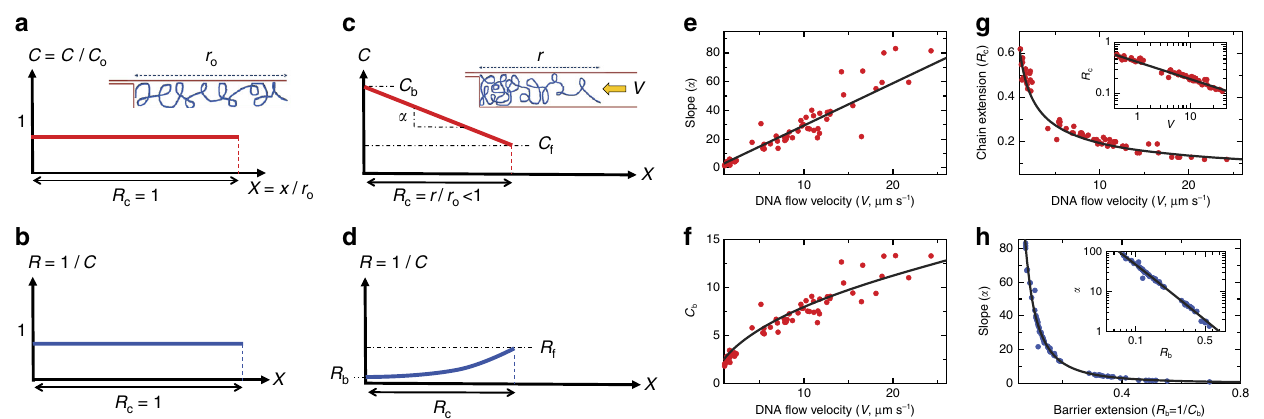
Fig. 2 Relation between the parameters de fi ned in concentration pro fi le. a The nanochannel con fi ned chain in no- fl ow equilibrium has a uniform concentration pro fi le C ( X ) = 1. Inset: schematic of no- fl ow equilibrium chain with extension r o . b Local extension R ( X ) ≡ 1/ C ( X ) for chain in no- fl ow equilibrium. c When a fl ow V is applied, in the long-time limit the chain reaches a steady-state with a concentration pro fi le that ramps linearly towards the barrier: C ( X ) = C b − α X. Inset: schematic of chain in fl ow-constrained equilibrium with extension r . d Local extension R ð X Þ (cid:3) 1 = C ð X Þ for chain in fl ow- constrained equilibrium. Note that for a uniform pro fi le R b = R c . e Pro fi le slope α , f barrier concentration C b , and g chain extension R c vs. V with fi ts to ffiffiffiffi p ffiffiffiffi p scaling relations predicted by piston theory ( e α (cid:4) V , f C b (cid:4) V and g R c (cid:4) 1 = V ). h Combining data in e and f yields α vs. R b , described well by the scaling α (cid:4) 1 = R 2 . The insets in g and h give the results on a log – b